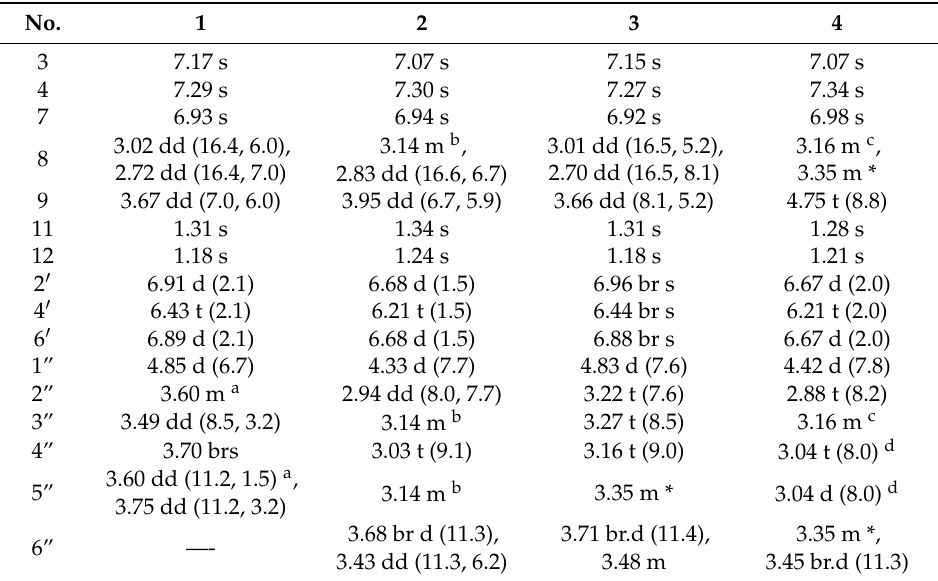
Table 1. 1 H-NMR (500 MHz, J in Hz) spectroscopic data of compounds 1 – 4 in DMSO- d 6 .